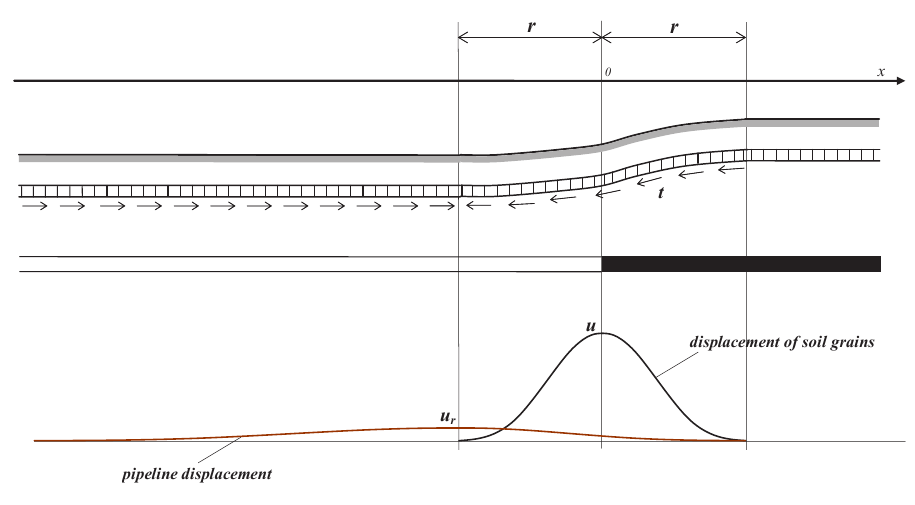
Fig. 4. Linear object consisting of butted segments on mining subsoil, Figure 4: Linear object consisting of butted segments on mining subsoil, u - soil displacement, u u - soil displacement, u r - object displacement The value of compressive forces acting on the pipeline within the range of main influences, i.e. along the line segment [- r;r ], will change according to the dependence